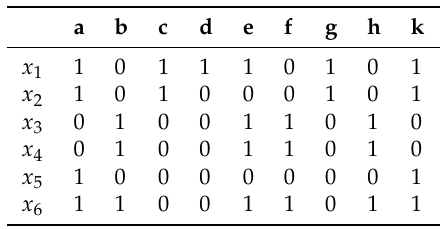
Table 7. A decision formal